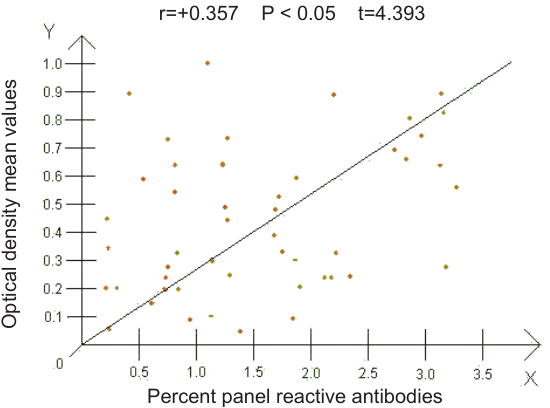
Figure 2. Correlation coefficient between percent panel reactive antibodies and mean optical density